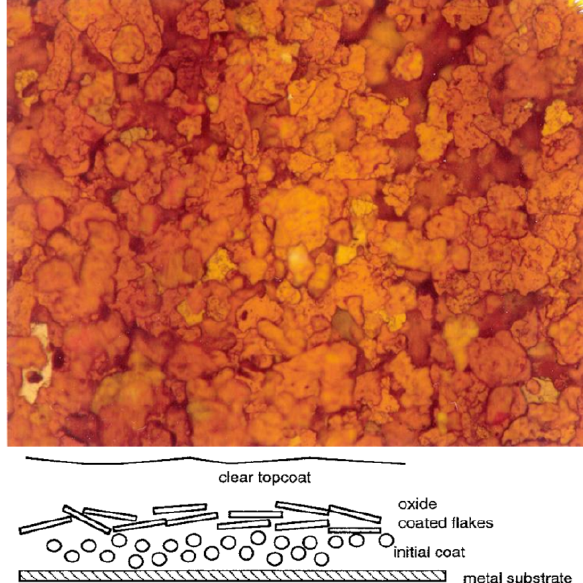
Fig. 12. Optical microscope image from above and cross-section schematic of the profile in a paint layer in which thin oxide-coated Al flakes provide both color and high solar reflectance [80].